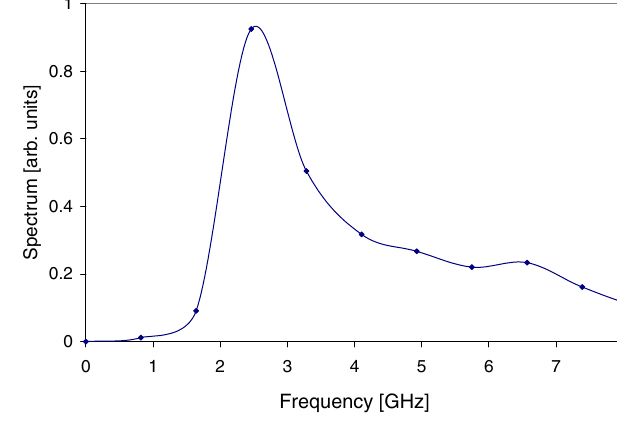
FIG. 5. (Color) Time dependence of the energy flow through the incoming (red) and outgoing (blue) chamber cross sections of the collimator. Scales are different by 100 times.